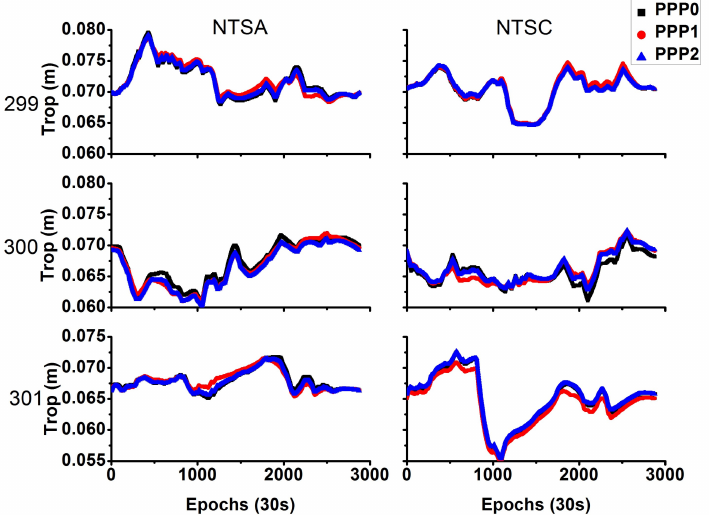
Figure 9. Comparison of residual tropospheric delay difference between different models ( left side represents NTSA station, and right side represents NTSC